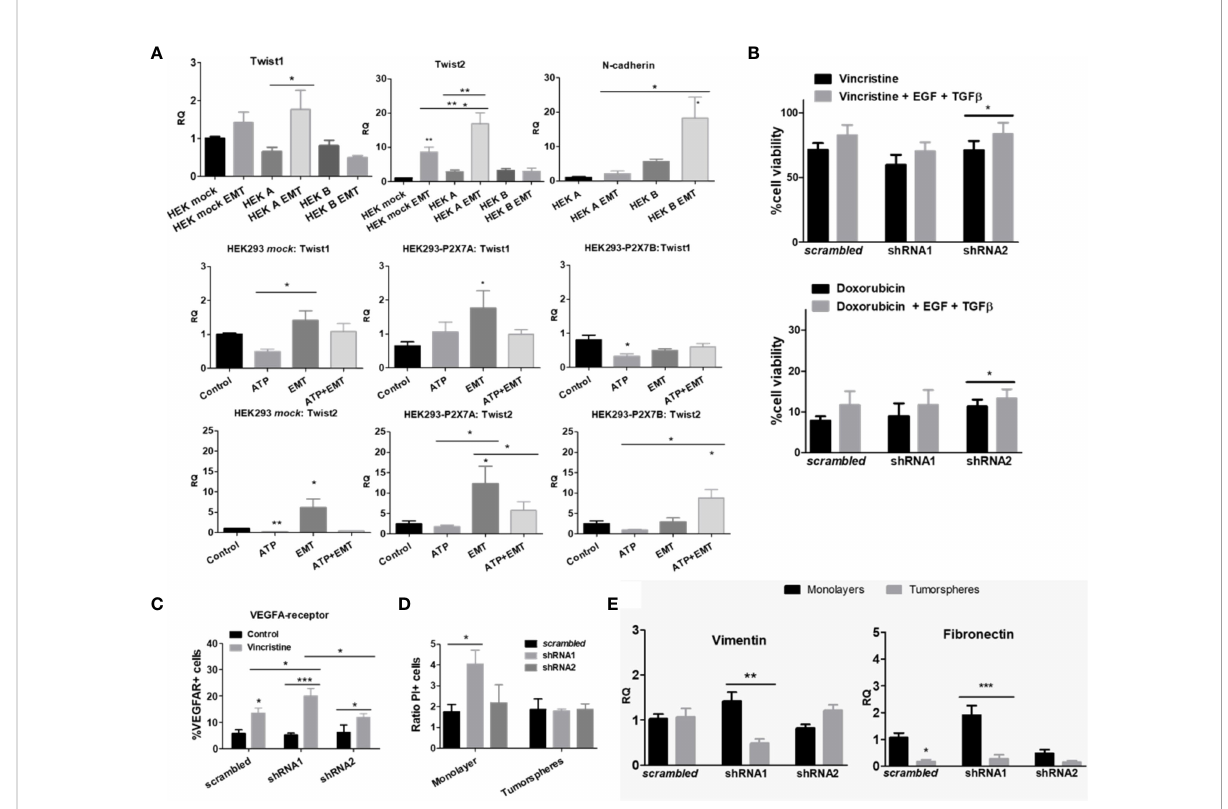
FIGURE 4 Epithelial-mesenchymal transition and stemness of cells cultured in monolayers or as tumorspheres. (A) mRNA expression levels of EMT-related transcription factors in HEK 293 cells, untreated, or treated with ATP and/or EMT inducers (EGF + TGF- b ) (n=3). (B) Cell viability measurements of vincristine- (n>=5) or doxorubicin-treated (n=4) ACN cells in the presence or absence of EMT inducers. Values were calculated as detailed in Methods section item 5. (C) Expression levels of the VEGF-A receptor protein in ACN cells treated with or without vincristine. Measurements were performed by fl ow cytometry. (n=3) (D) Cell death ratio of ACN cells cultured in monolayers or as tumorspheres upon treatment with vincristine. For normalization of cell death intrinsic to tumorsphere manipulation, values were calculated as detailed in Methods section item 5. (E) mRNA expression levels of vimentin and fi bronectin in ACN cells cultured in monolayers or as tumorspheres (n=3). * p <0.05; ** p <0.01; *** p